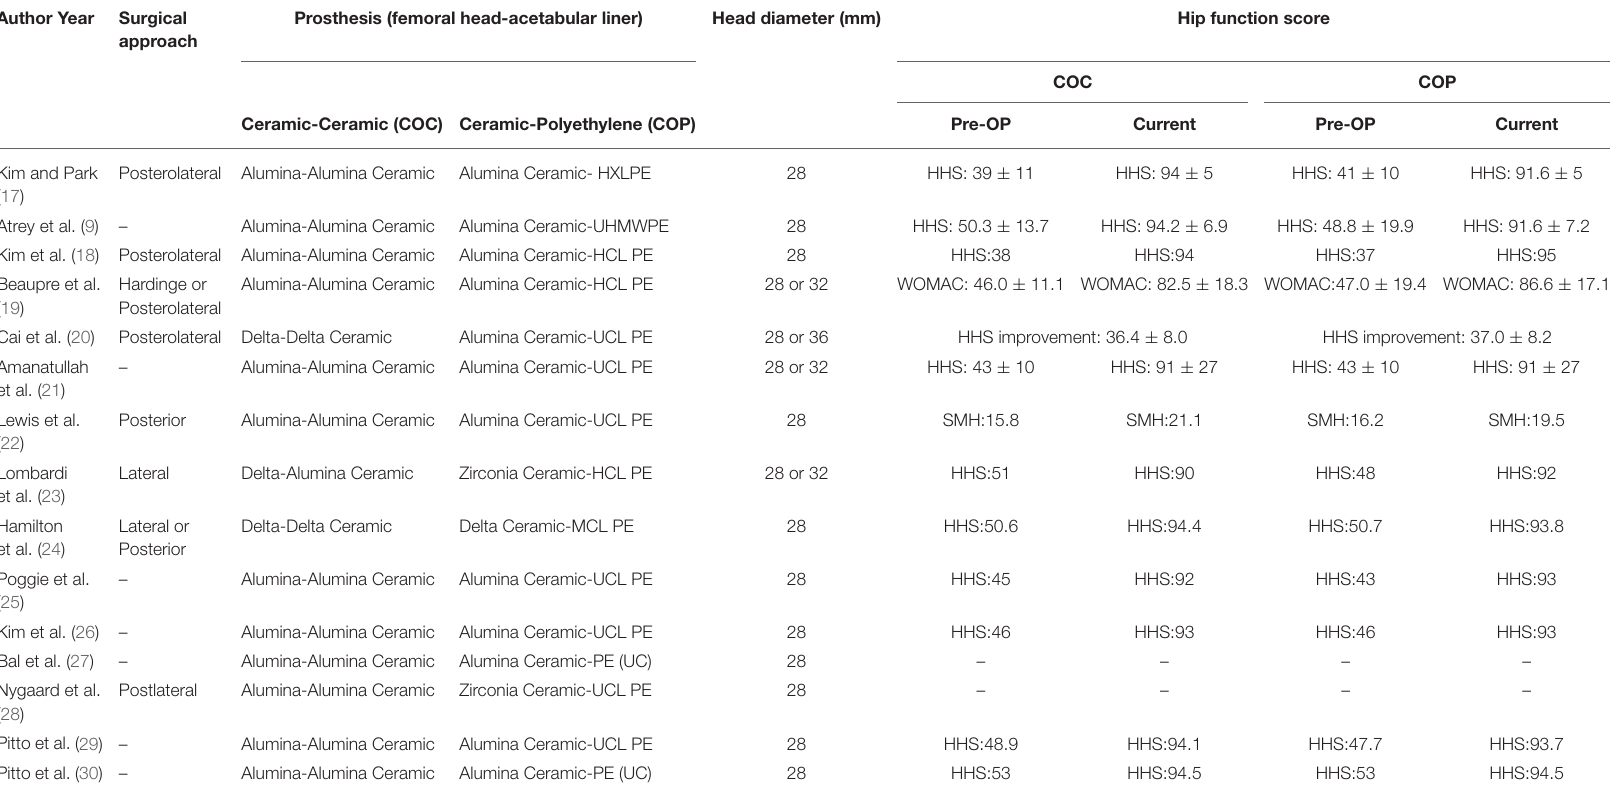
TABLE 2 | Characteristics of included trials showing general surgical